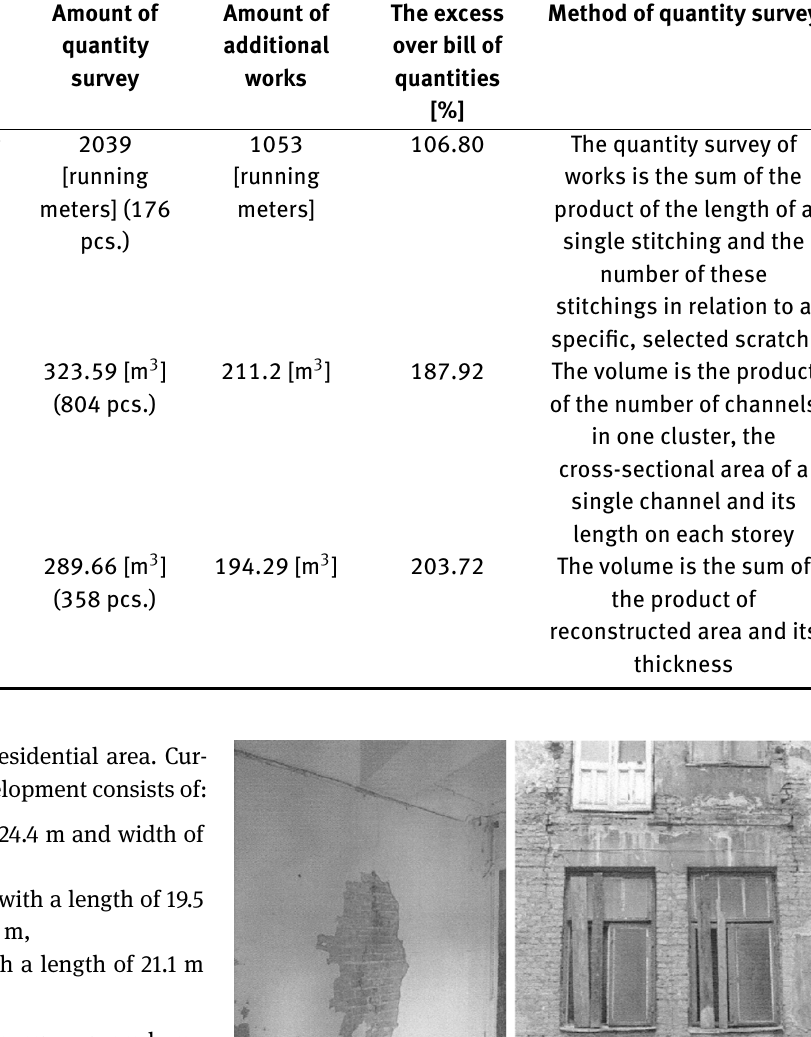
Table 1: List of bill of quantities and quantity survey of selected renovation works No. Description of works